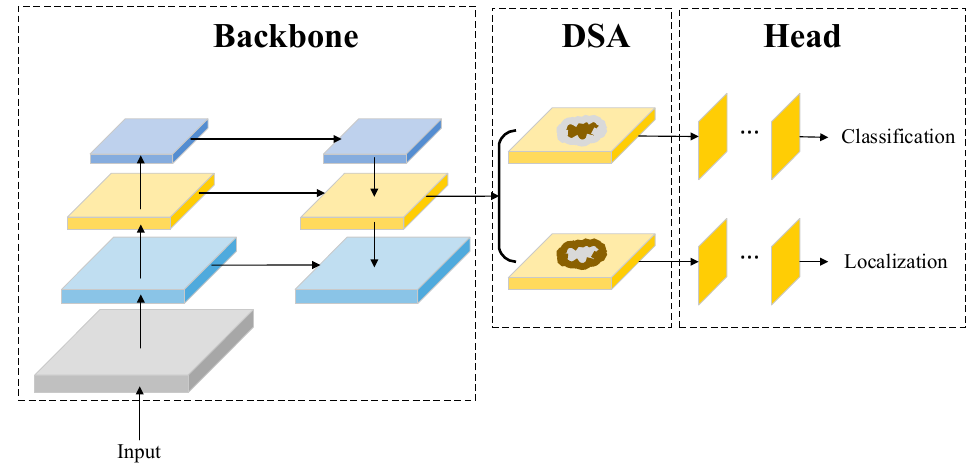
Figure 2. The network architecture of DSANet object detection model. DSANet is based on RetinaNet and includes three modules: backbone network module, DSA module and head network module. Compared with RetinaNet, DSANet adds a DSA module between backbone network and head network. DSA uses the self-attention mechanism to learn suitable features for tasks. It includes two branches, and each branch is unique to each task.